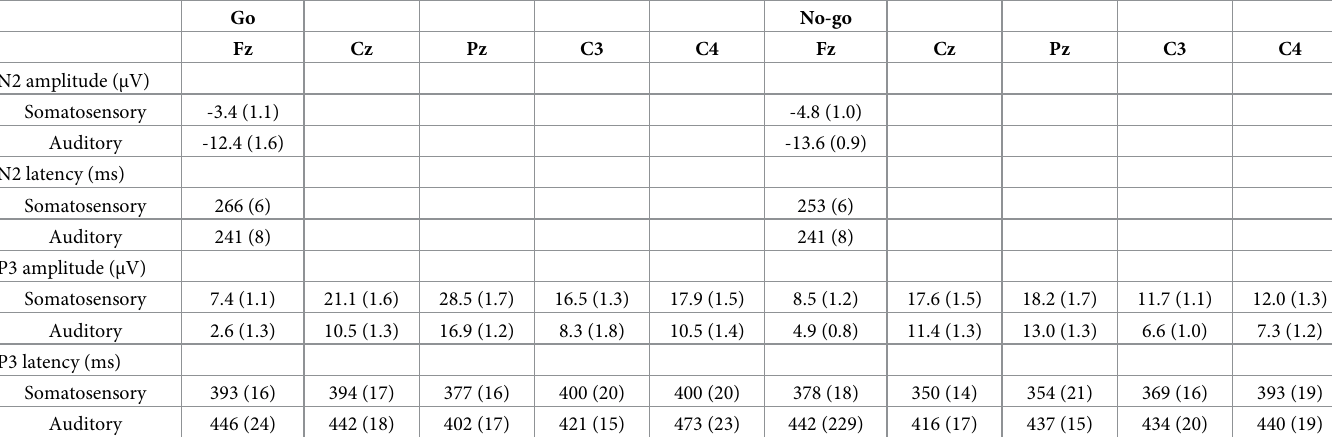
interaction (F (2, 34) = 30.570, p < 0.001, η 2 = 0.643). A post-hoc Bonferroni test of the Trial- Electrode interaction showed that the peak amplitudes of Go-P3 were significantly larger at Pz than at Fz and Cz (p < 0.001, respectively), and at Cz than Fz (p < 0.001, respectively). In con- trast, the peak amplitudes of No-go-P3 during auditory and somatosensory paradigms were significantly larger at Pz than at Ft and Cz (p < 0.001, respectively). These data indicate that No-go-P3 has a more anterior distribution relative to Go-P3, the so-called ‘anteriorization’ of No-go-P3. In addition, we examined the normalized amplitude values to clarify the differences in the scalp topography [37]. ANOVAs revealed a significant main effect of Electrode (F (2, 34) = 178.071, p < 0.001, η 2 = 0.913), and Trial-Electrode interaction (F (2, 34) = 6.320, p = 0.005, η 2 = 0.271). This interaction indicates the different distribution between Go and No-go trials (Fig 2). However, the three two-way interactions were superseded by a three-way interaction of Modality-Trial-Electrode (F (2, 34) = 4.498, p = 0.018, η 2 = 0.209). Decomposi- tion of the three-way interaction facilitated examination of Modality-Stimulus within each electrode and revealed a Modality-Stimulus interaction only at Pz (F (1, 17) = 11.193, p = 0.04, η 2 = 0.397). This two-way interaction indicated that the peak amplitude of Go-P3 was larger than that of No-go-P3 during the somatosensory paradigms (F (1, 17) = 15.310, p = 0.001, η 2 = 0.474), whereas no such difference was observed during the auditory paradigms (F (1, 17) = 1.003, p = 0.331, η 2 = 0.056).